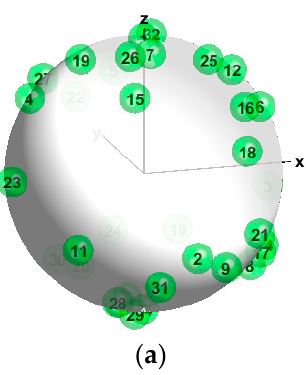
Figure 6. Normal bearing force as functions of diameter and thickness for cylindrical N42 NdFeB